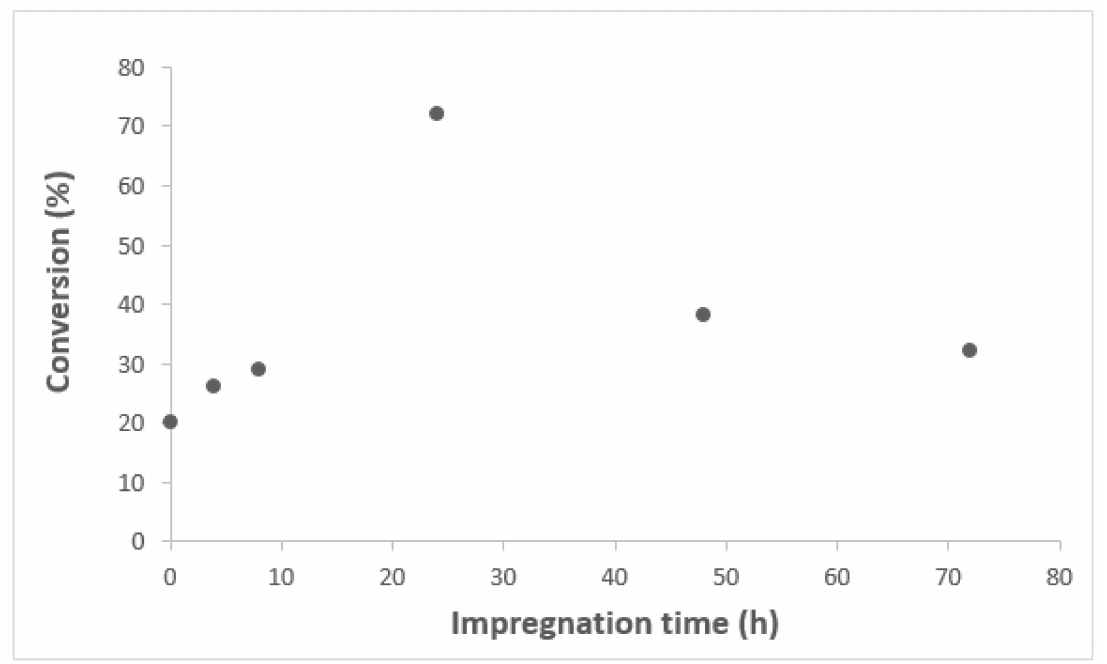
Figure 3. Effect of catalyst impregnation time on catalytic activity. Impregnation conditions: i -Pd(OAc) 2 (TPPTS) 2 (10 µ mol Pd), 5 mL ethanol, 60 ◦ C, 1 atm air. Reaction conditions: 0.925 mmol benzyl alcohol, i -Pd(OAc) 2 (TPPTS) 2 (10 µ mol, Pd)